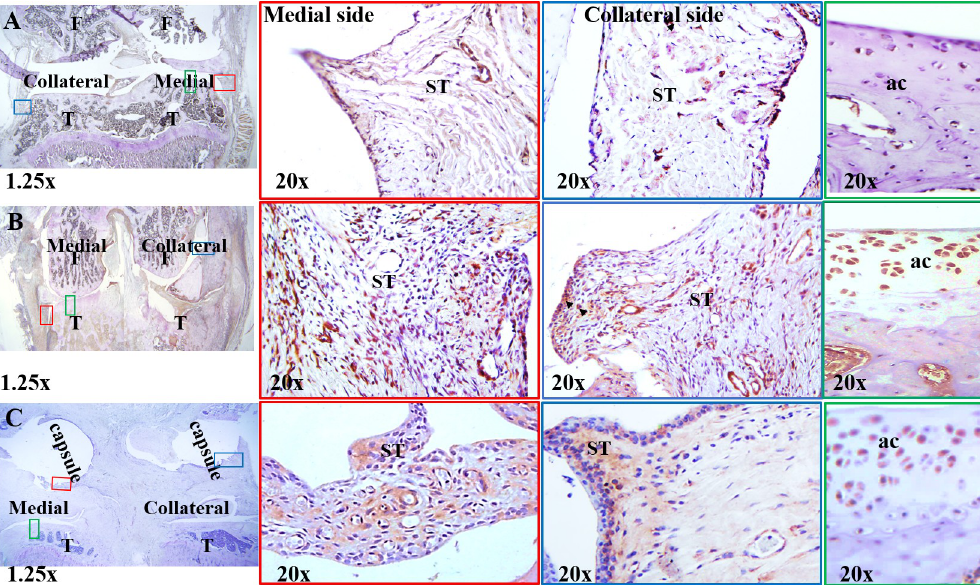
Fig 6. CCL21 synthesis was increased in response to MMD compared sham-operated knees. Immunohistochemistry staining was performed using antibodies against rat CCL21 antibodies for both sham- ( A ) and MMD- operated knees ( B and C ), collected from rats at day 3 ( A and B ) and 4 weeks ( C ) post-surgeries. Representative images of histology sections collected from Sham- ( A ) and MMD-operated knees ( B and C ), brown color represents CCL21 positive areas. Arrowheads show some of CCL21 positive stained areas. The small squares on the left panels represent the areas magnified 20x on the right panels. T. tibia plateau, F. femur condyle, ST, synovial tissue. A , B and C images were taken using 1.25x microscope